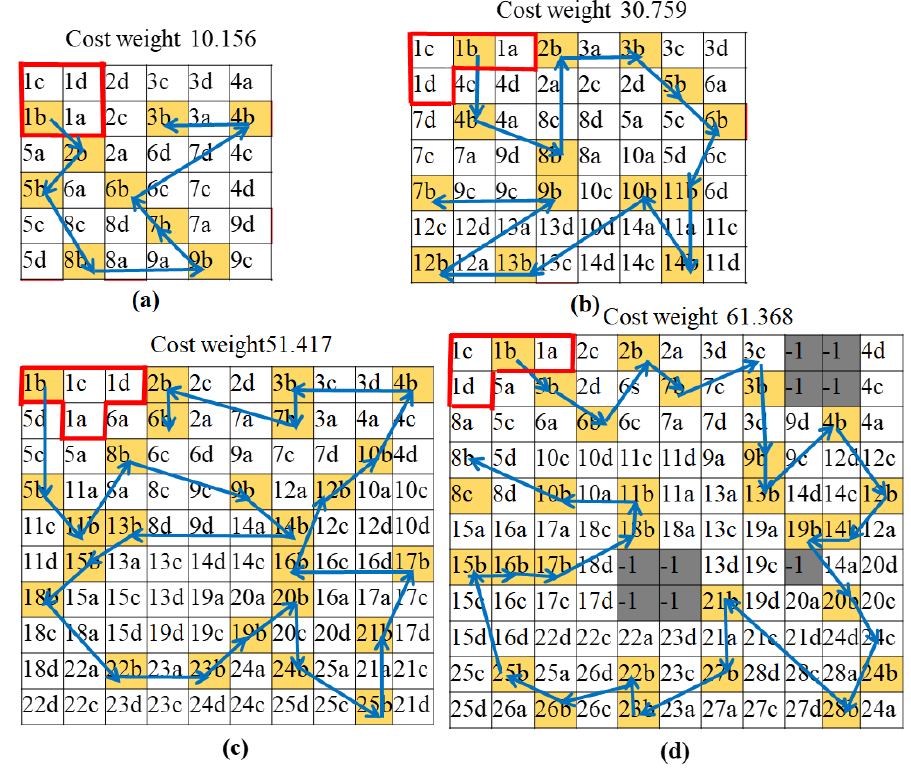
Figure 13. Path generated for the different workspaces with different shapes. ( a ) Optimal path for 6 × 6; ( b ) Optimal path for 8 × 7; ( c ) Optimal path for 10 × 10; ( d ) Optimal path for 11 ×